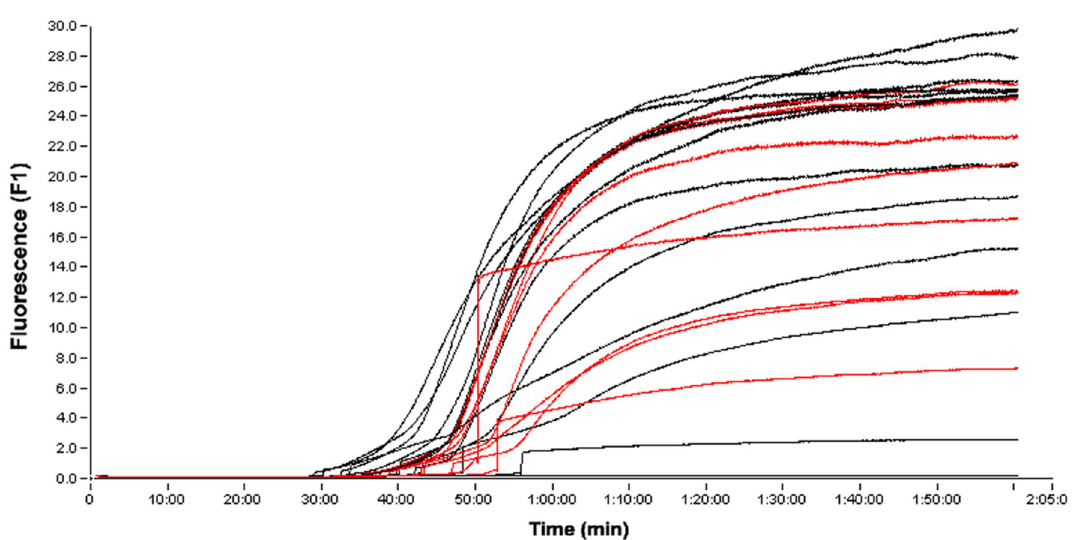
Figure 7. Measured fluorescence of conventional LAMP amplification of positive control samples (red lines, n = 13) and negative control samples modeling contamination (black lines, n =